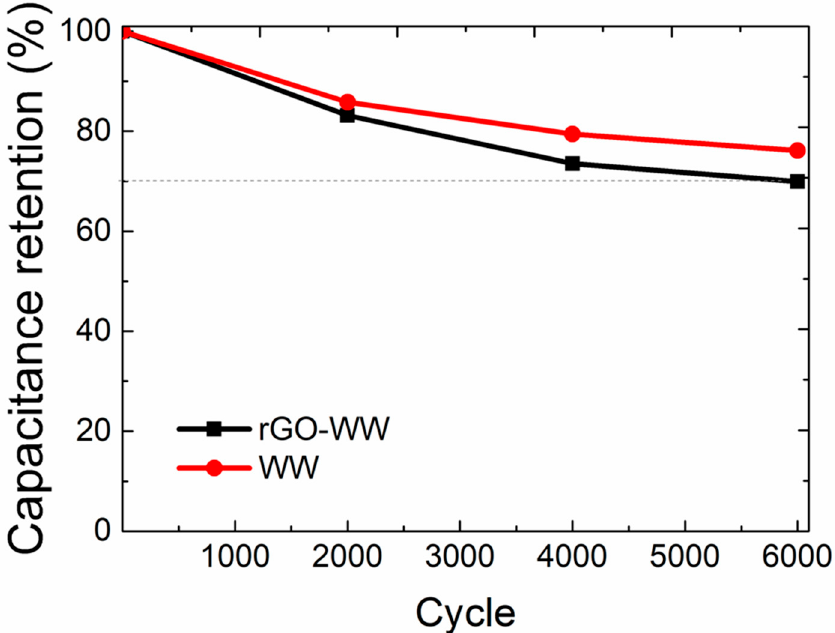
Figure 7. Capacitance evolution along cycles of indicated samples measured at 10 A·g − 1 in the organic electrolyte.